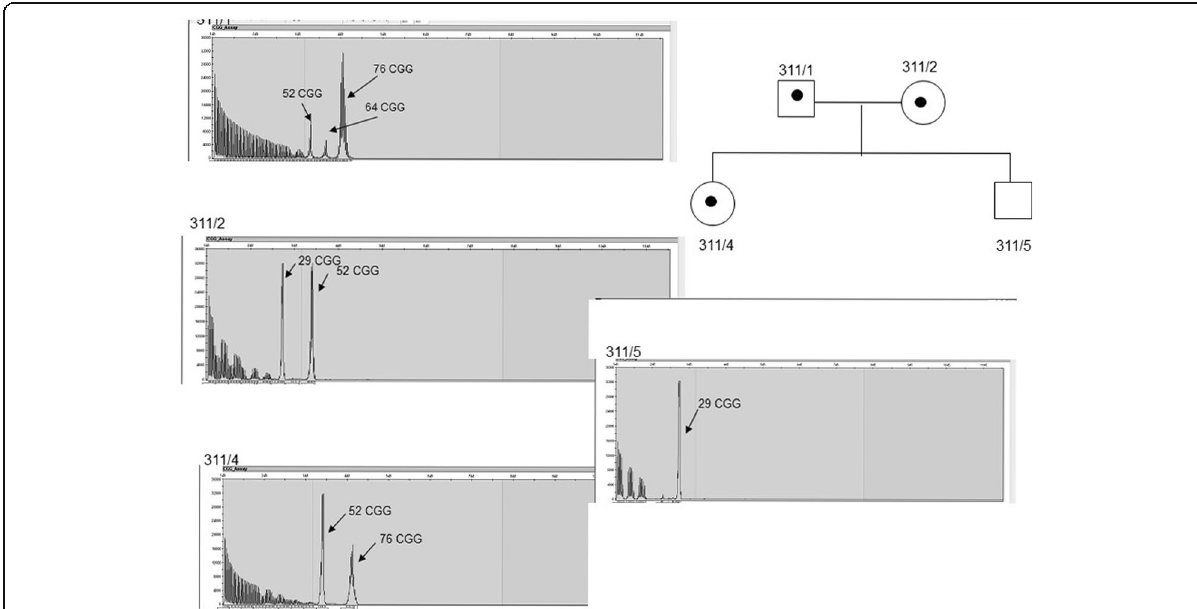
Fig. 3 Paternal and maternal inheritance (PIP and MIP) with paternal mozaicism. The figure shows the family No.6 (code 311), where the maternal and paternal inheritance was observed in parallel (PIP and MIP). The patient inherited the paternal premutation allele, and the maternal allele with the repeat number within the gray zone. We detected mosaic form for the father with 52/64/76 CGG repeat numbers. The patient inherited the paternal 76 CGG repeat number allele, and the maternal 52 CGG repeat number